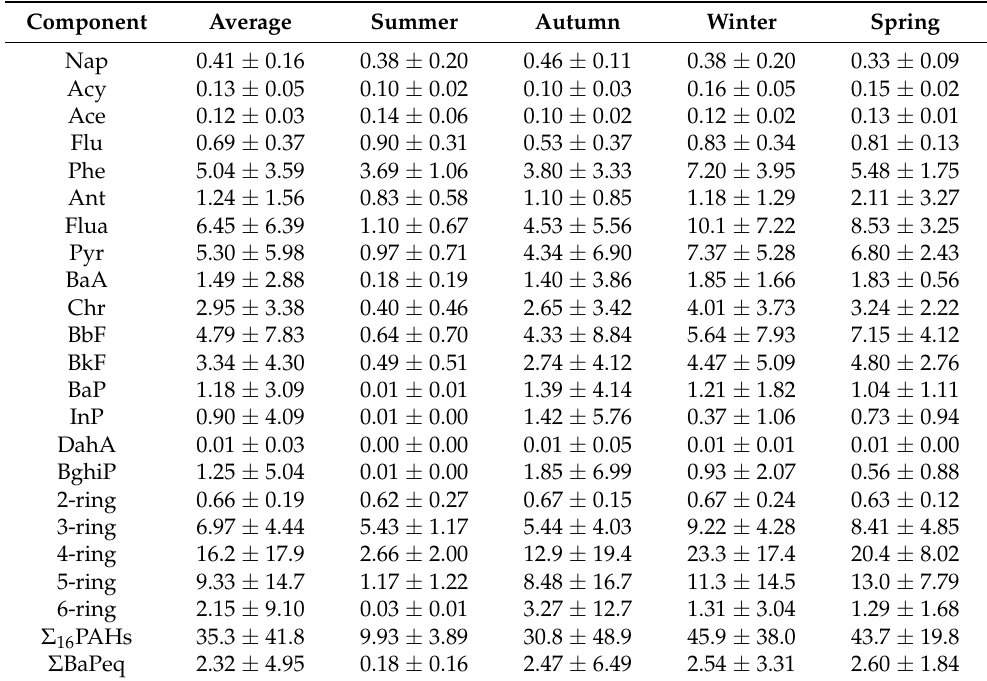
Table 1. The mean ± standard deviation of PM 2.5 -bound PAH concentrations and BaPeq concentra- tions on Beihuangcheng Island from August 2017 to March 2018 (unit: ng/m 3 ).